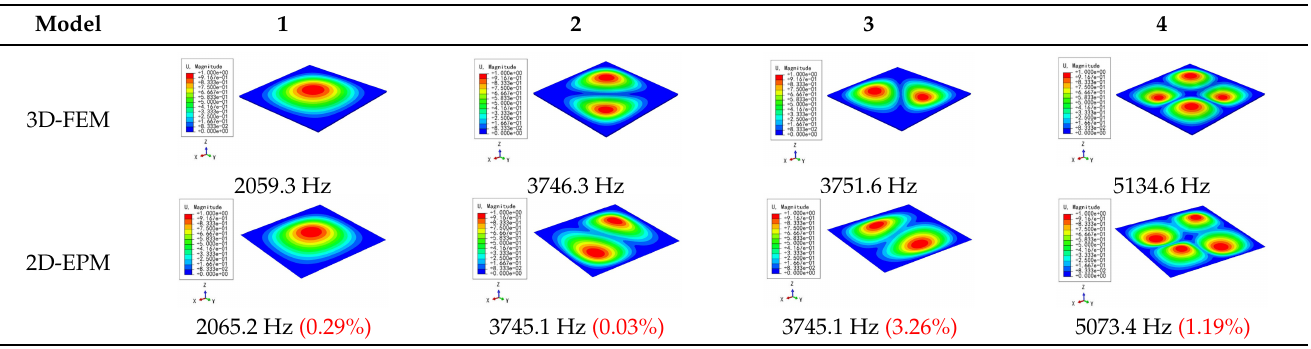
Table 15. Comparison of the first four free vibrations of the X-shaped HSP under CCCC boundary conditions predicted by different